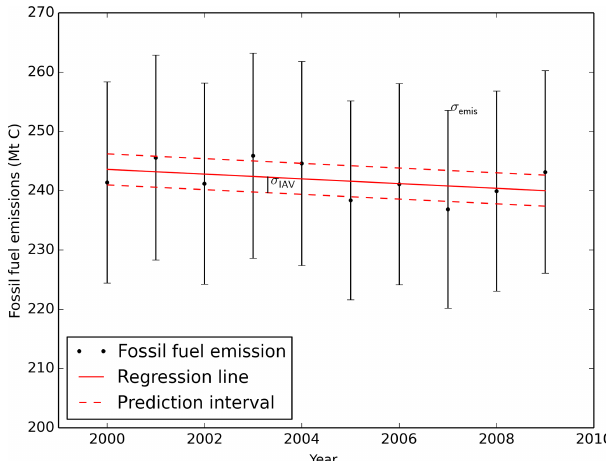
Figure C1. Annual FFCO 2 emissions from Germany in the period 2000–2009 calculated from